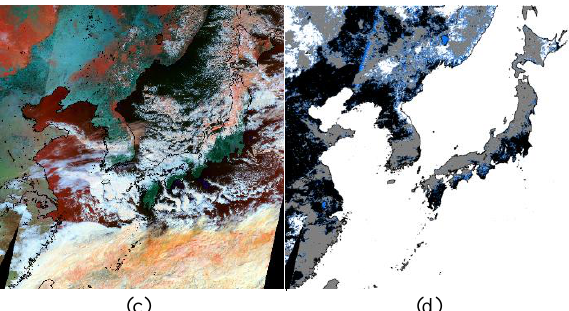
Figure 3. (a) SWIR color composite Terra-MODIS daily surface reflectance (b) Terra-MODIS daily snow products (MOD10A1) in Dec 12, 2011 (white: snow cover, grey: clouds, black: clear land surface, and blue: water and